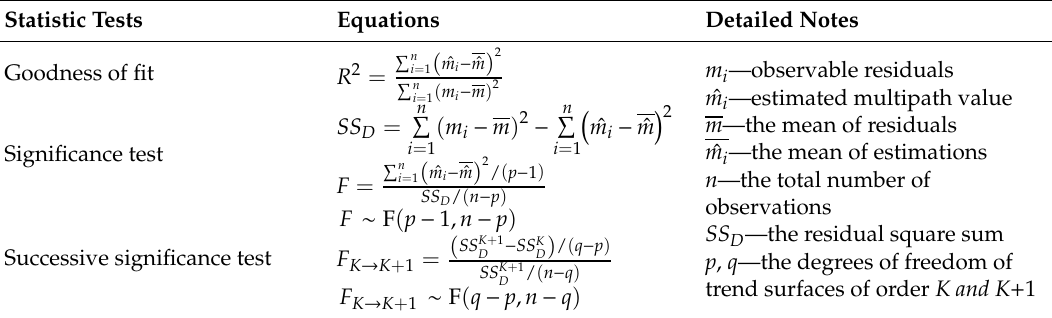
Table 1. Statistical tests of trend surface analysis.